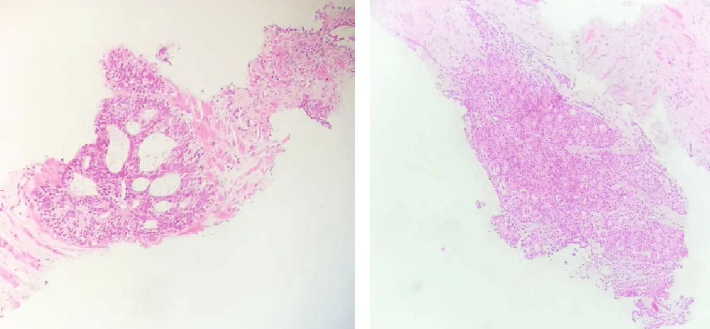
Figure 3: Hematoxylin eosin ( × 100): in fi ltration of the prostatic parenchyma by a grade 4 acinar prostatic adenocarcinoma 4.